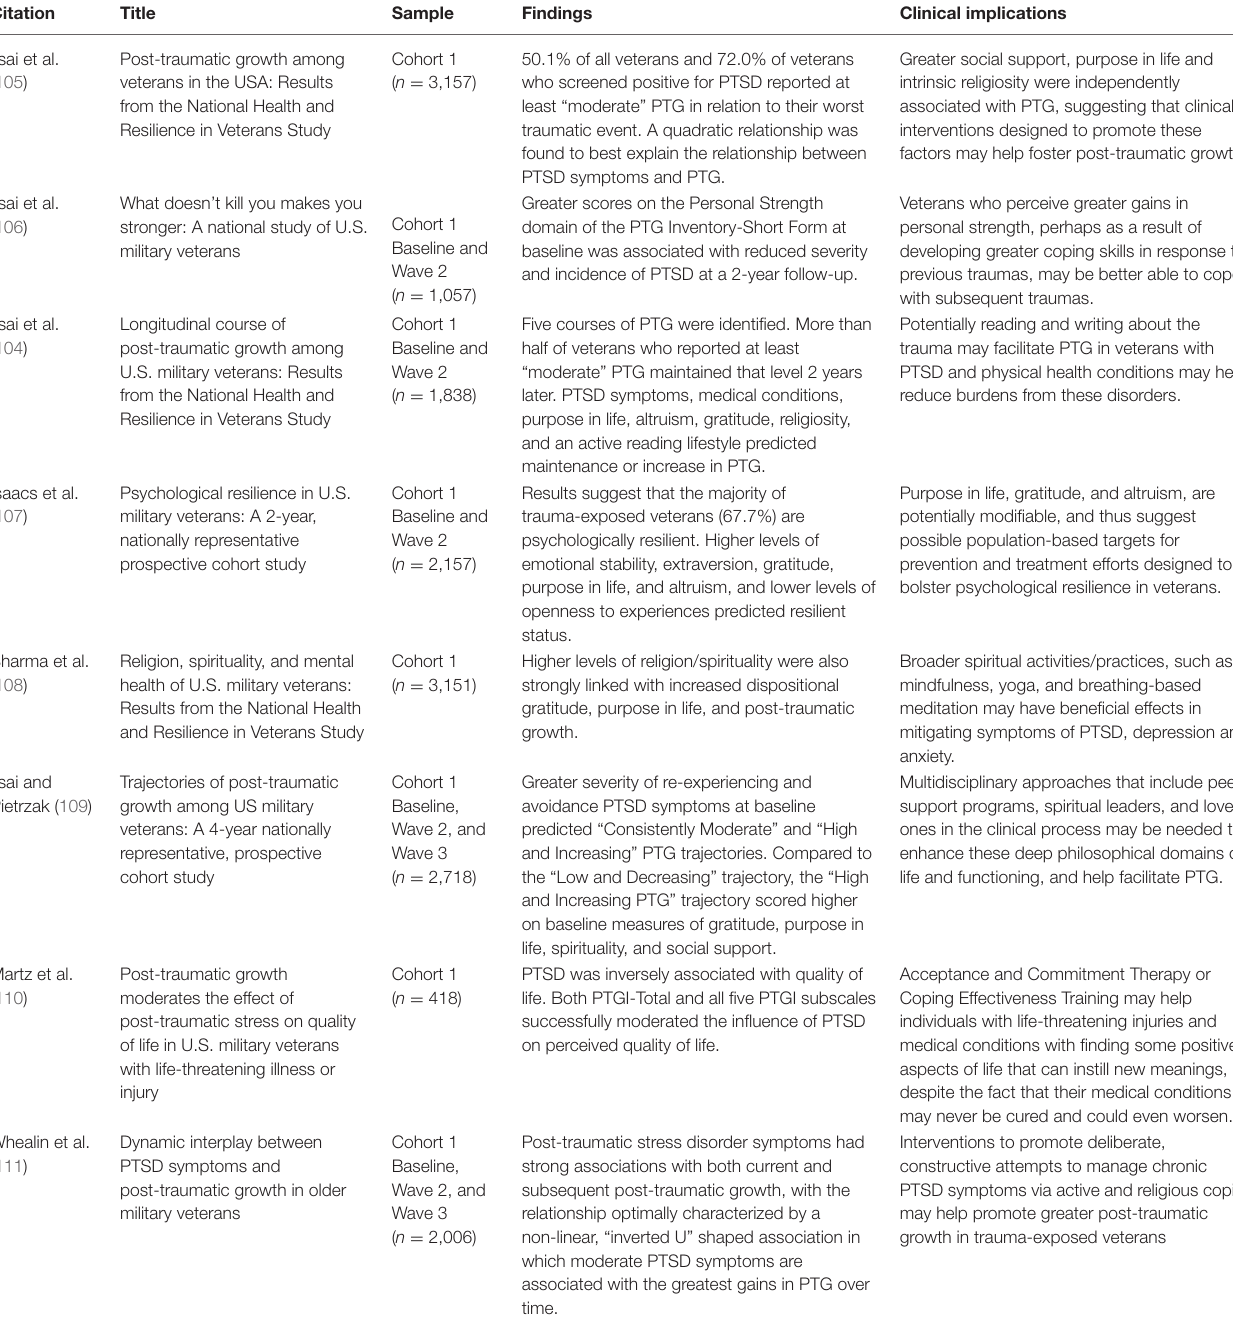
TABLE 5 | Resilience and post-traumatic